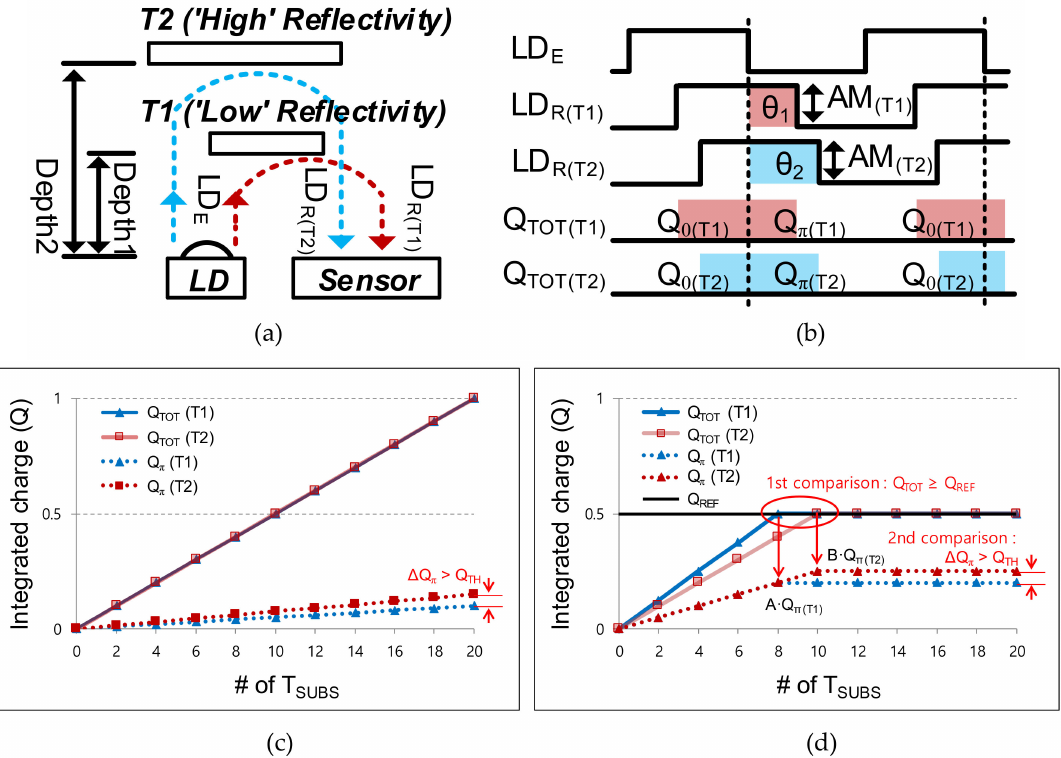
Figure 2. Operation principles for detecting the depth frame di ff erence: ( a ) example of detecting two objects with di ff erent reflectivities at di ff erent distances; ( b ) timing diagram; ( c ) integrated charges from two objects in the case that provides the same total charges; ( d ) integrated charges from two objects in the case that provides di ff erent total charges. For illustration, we described Q in the range of 0–1. Q π is the charge integrated by the out-of-phase (180 ◦ ) modulation, Q TOT is the sum of Q 0 and Q π , and Q REF is the reference of the first